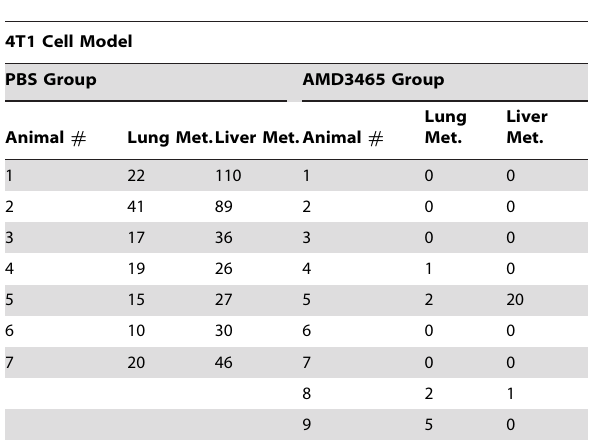
Table 1. AMD3465 Inhibits Breast Cancer Metastases.